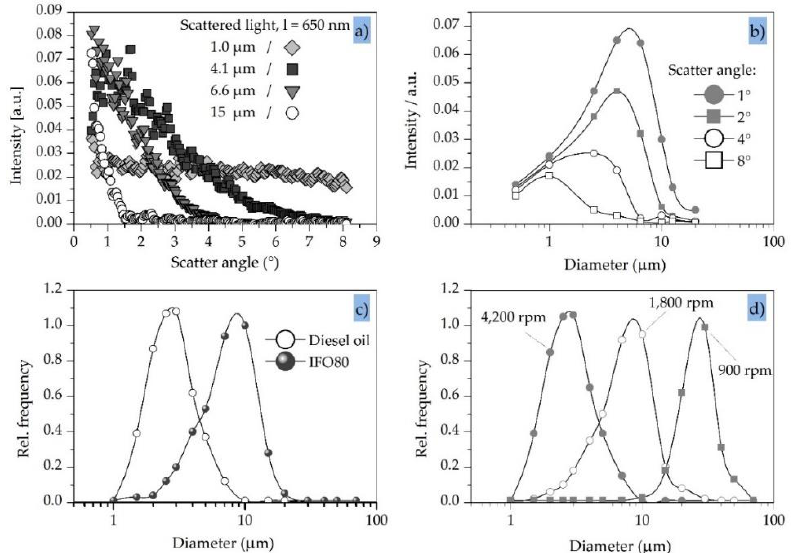
Figure 3. Characteristics of scattered light detection using model particles / droplets. ( a ) Typical scatter pattern using monodisperse particles made of polystyrene / IF080 (sticky crude oil). ( b ) Sensitivity of specific scatter angles to di ff erent particle diameters ( λ = 650 nm). ( c ) Droplet size distribution using a three-stage rotational pump at di ff erent revolution speeds. ( d ) Droplet size distribution in diesel oil using a three-stage rotational pump for two di ff erent oil